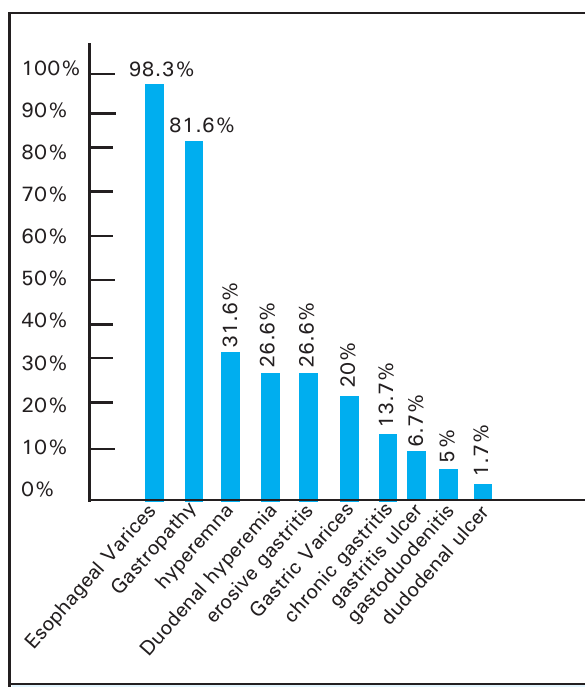
Figure 1. Upper gastrointestinal endoscopic observa- tion in portal hypertension.